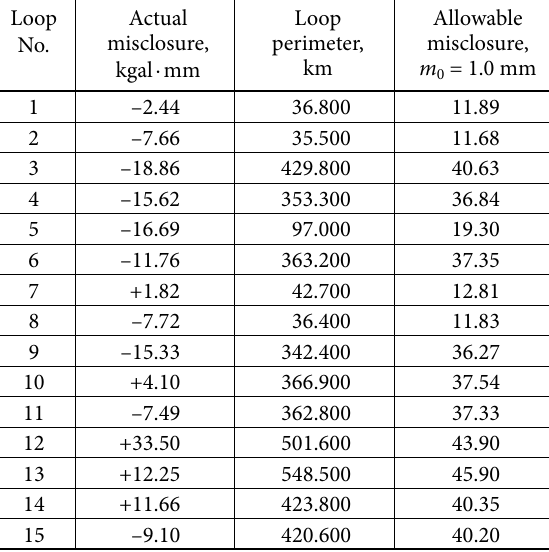
Table 1. Misclosures of loops of the Latvian NFOLN Loop